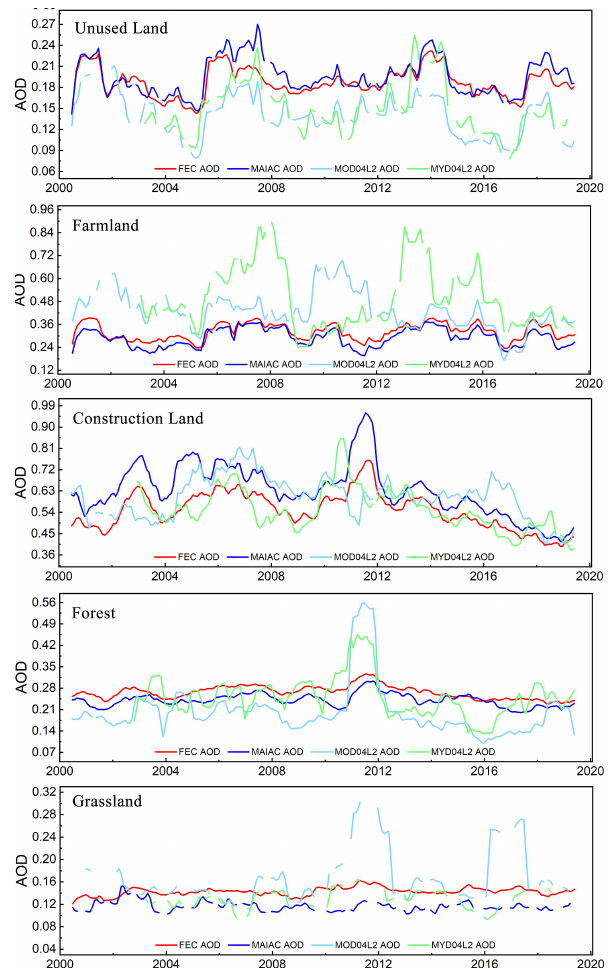
Figure 7. The long-term change trends of four AOD products over five ecological zones obtained by removing seasonal